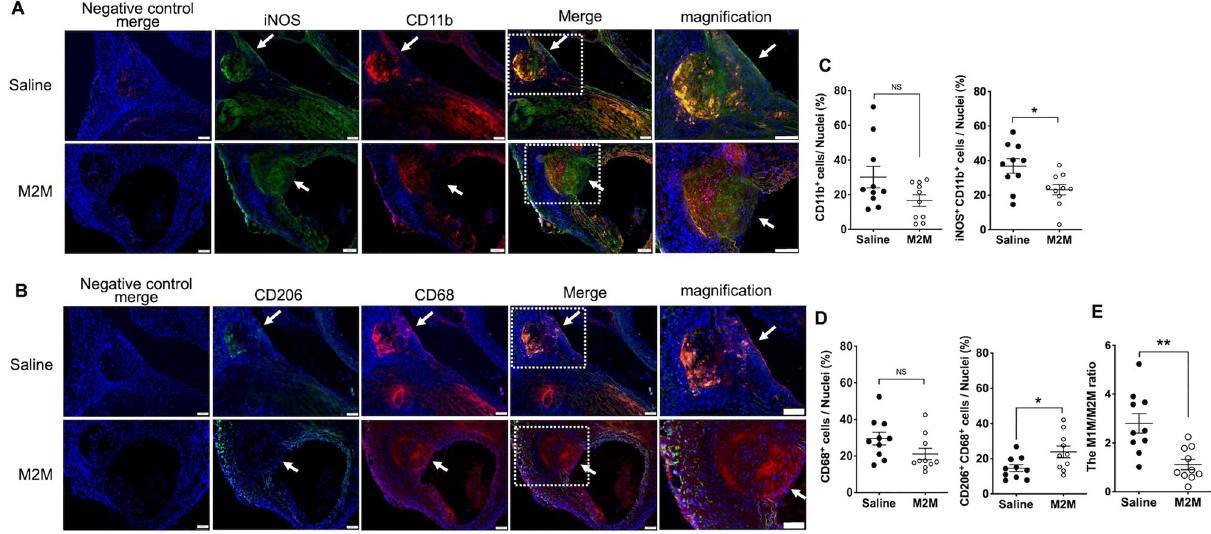
Figure 4. Representative images of immunofluorescence staining. ( A ) iNOS, used to detect M1Ms, is shown in green, while CD11b, used to detect macrophages, is shown in red. ( B ) CD206, used to detect M2Ms, is shown in green, while CD68, used to detect macrophages, is shown in red. Nuclei are shown in blue. Scale bars = 100 µm. ( C ) Quantitative analysis of cells positive for CD11b and iNOS. (D) Quantitative analysis of cells positive for CD68 and CD206. ( E ) The ratio of M1Ms to M2Ms. Data are means ± SEM. * p < 0.05 and ** p < 0.01 assessed by the Mann–Whitney U test. M1M: M1 macrophage, M2M: M2 macrophage, NS: not significant.